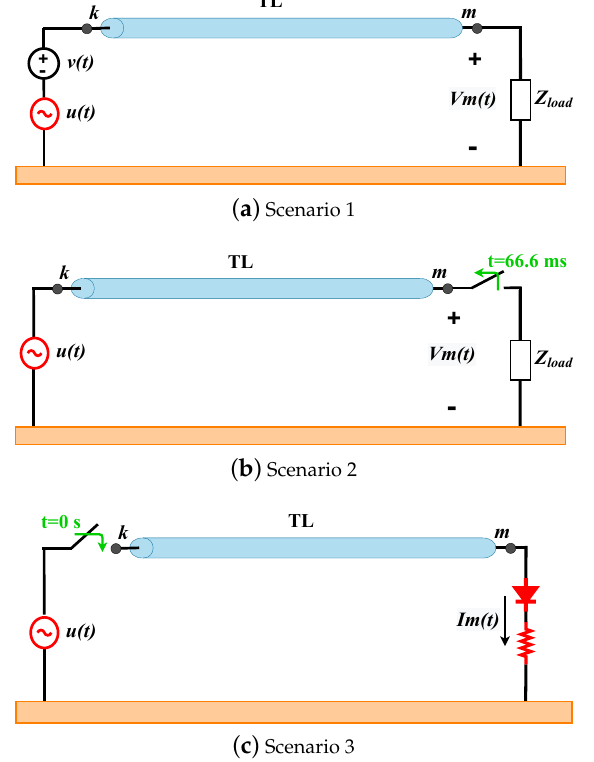
Figure 8. Single-phase TLs studied in an: ( a ) open-circuit test, ( b ) load rejection test and ( c ) nonlinear load